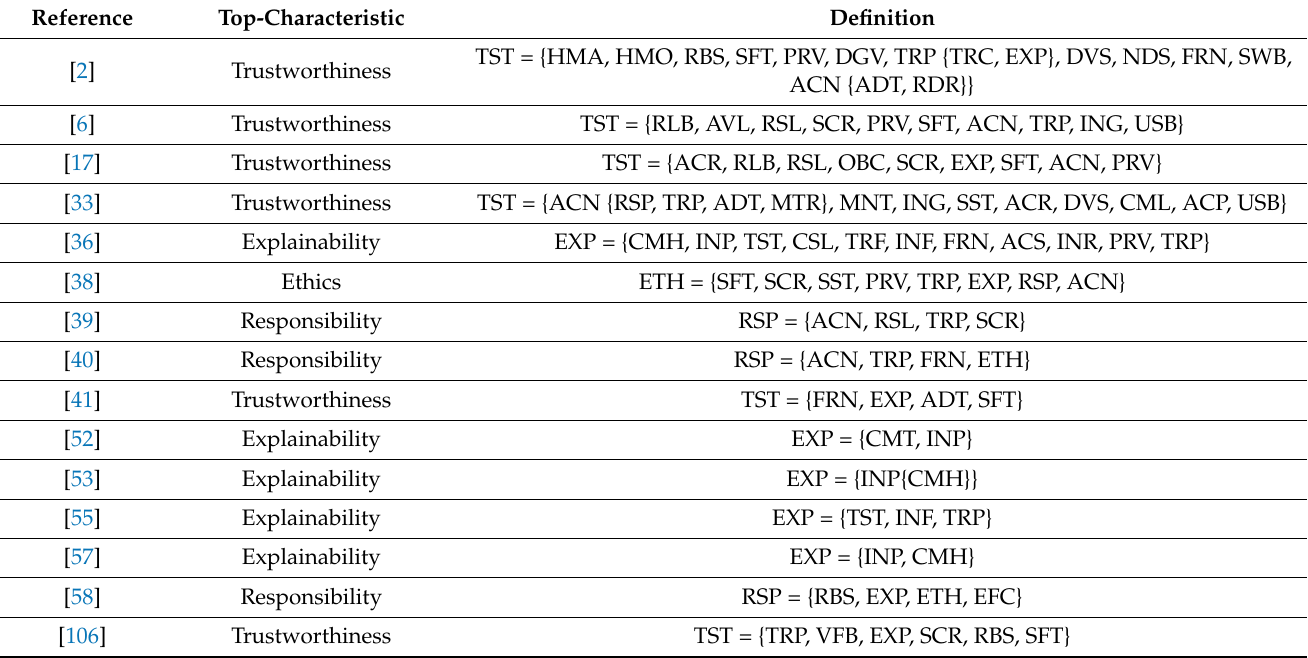
Table 4. Results of the coded references analysis.